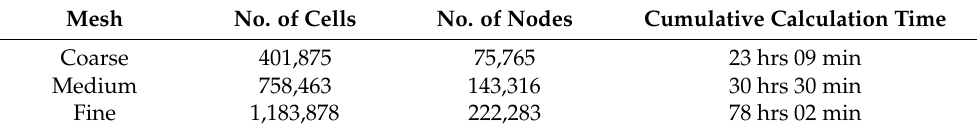
Table 3. Properties of the meshes used for mesh independence analysis.